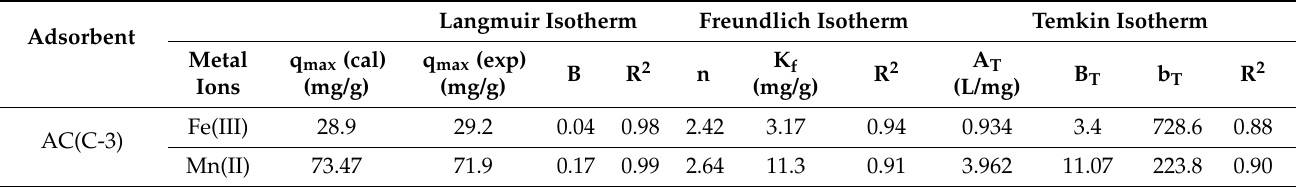
Table 10. Parameters of Langmuir and Freundlich for Fe(III) and Mn(II) adsorption using AC(C-3), respectively. Adsorbent